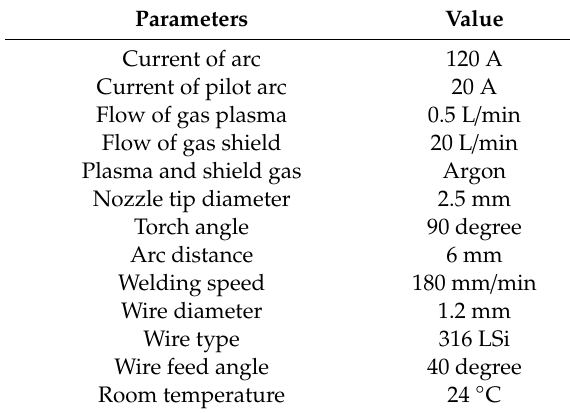
Table 3. Parameters for hot wire plasma arc welding.